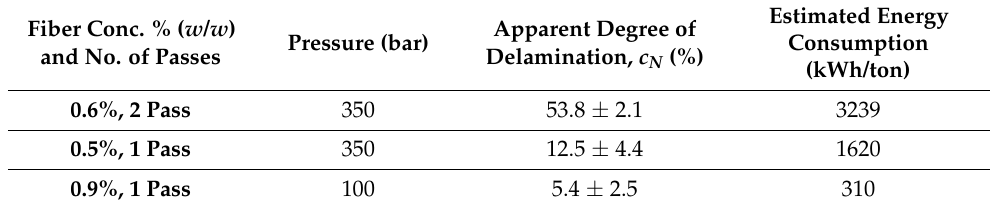
Table 2. Apparent degree of delamination comparison at different homogenization